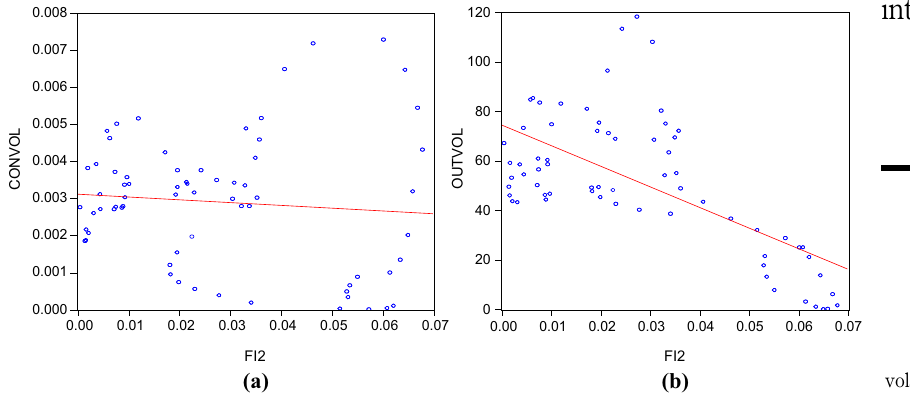
Figure 2. Correlations